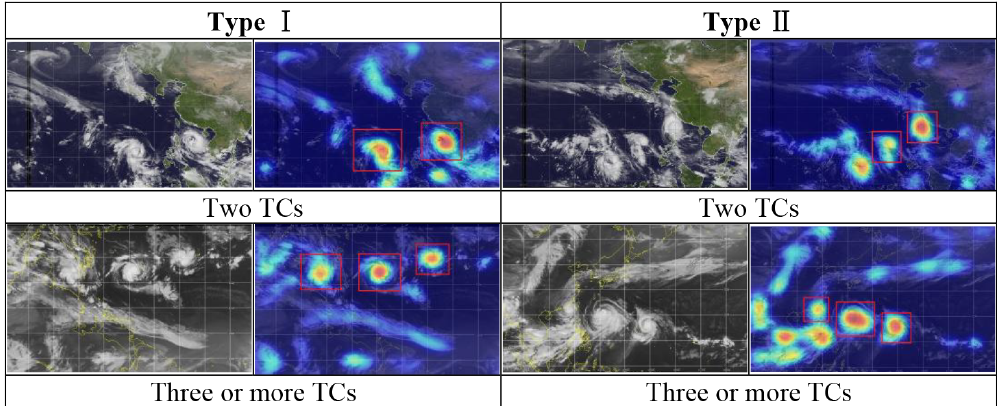
Figure 21. Heat maps of some successfully identified TC images compared with associated NWPO images that involve multiple